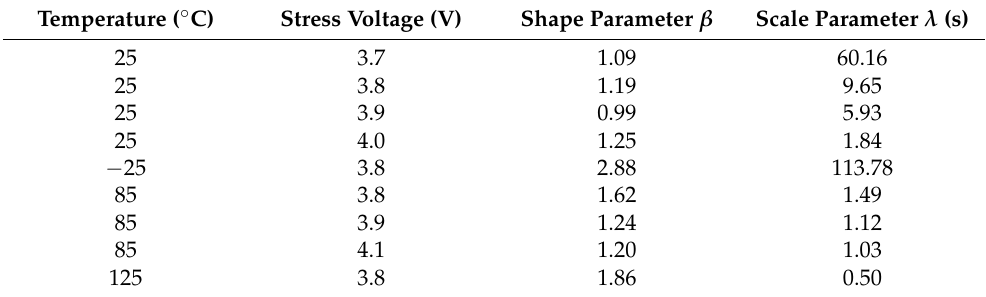
Table 2. Weibull distributions for time-dependent breakdown for forming process of investigated RRAM devices at various temperatures and different stress voltages. Temperature ( ◦ C) Stress Voltage (V) Shape Parameter β Scale Parameter λ